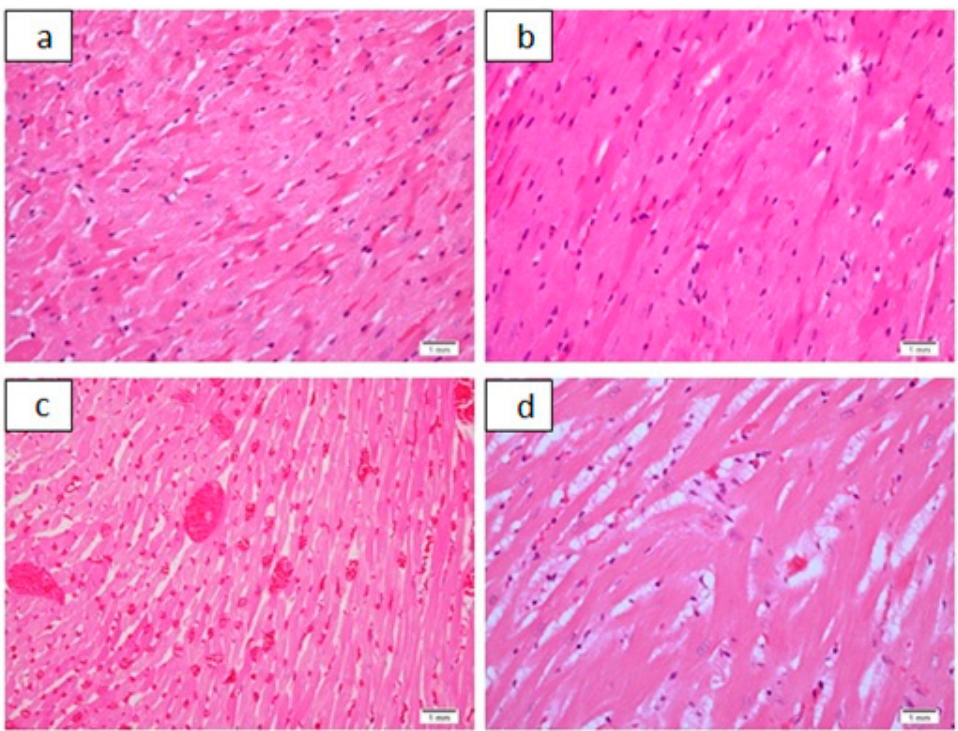
Figure 6. Cardiac histological findings as seen in acute toxicity study. ( a ): Moderate cardiac muscle fiber hyalinization, H&E, ×20. ( b ): Moderate cardiac muscle fiber hyalinization, H&E, ×40. ( c ): Marked cardiac congestion, H&E, ×20. ( d ): Mild cardiac cytoplasmic vacuolization, H&E, ×40.